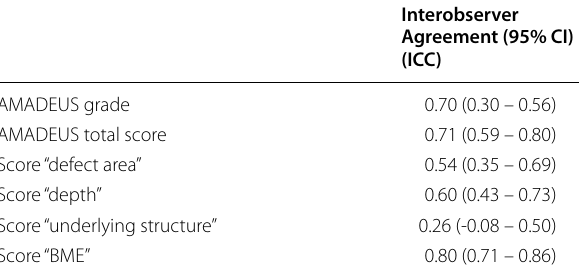
Table 2 Intraclass correlation coefficients for interobserver